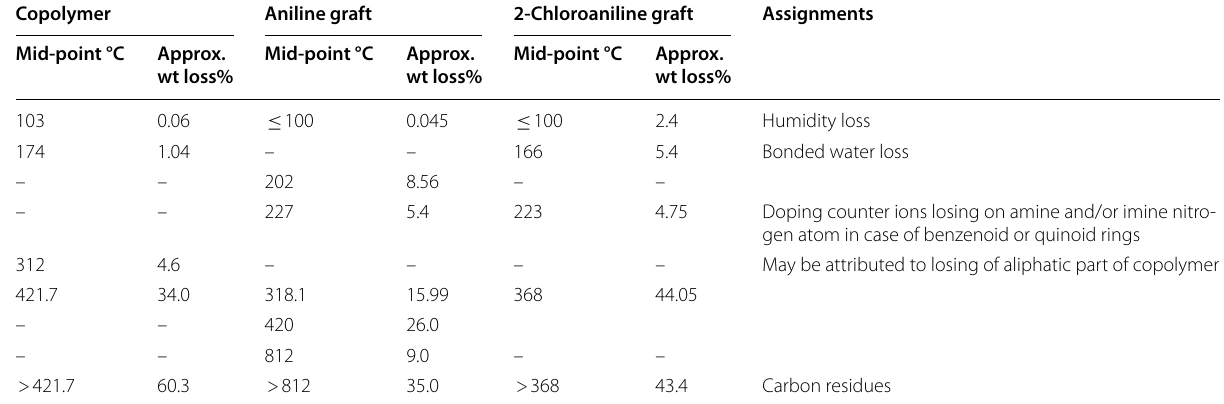
Table 2 TGA data of the synthesized polymeric samples